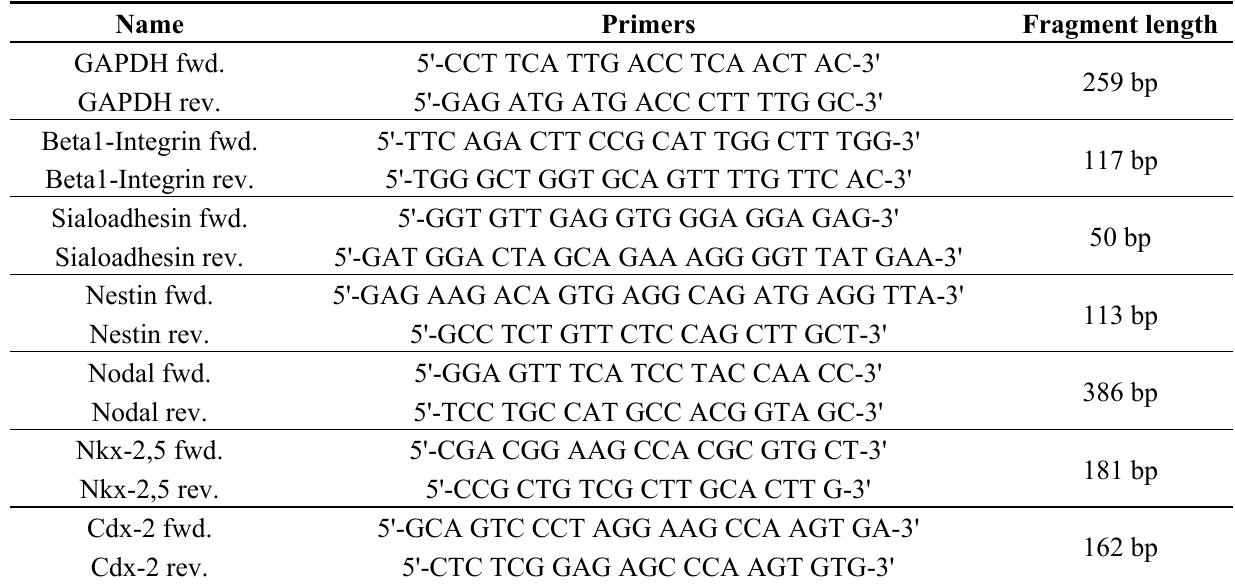
Table 1. List of all primers